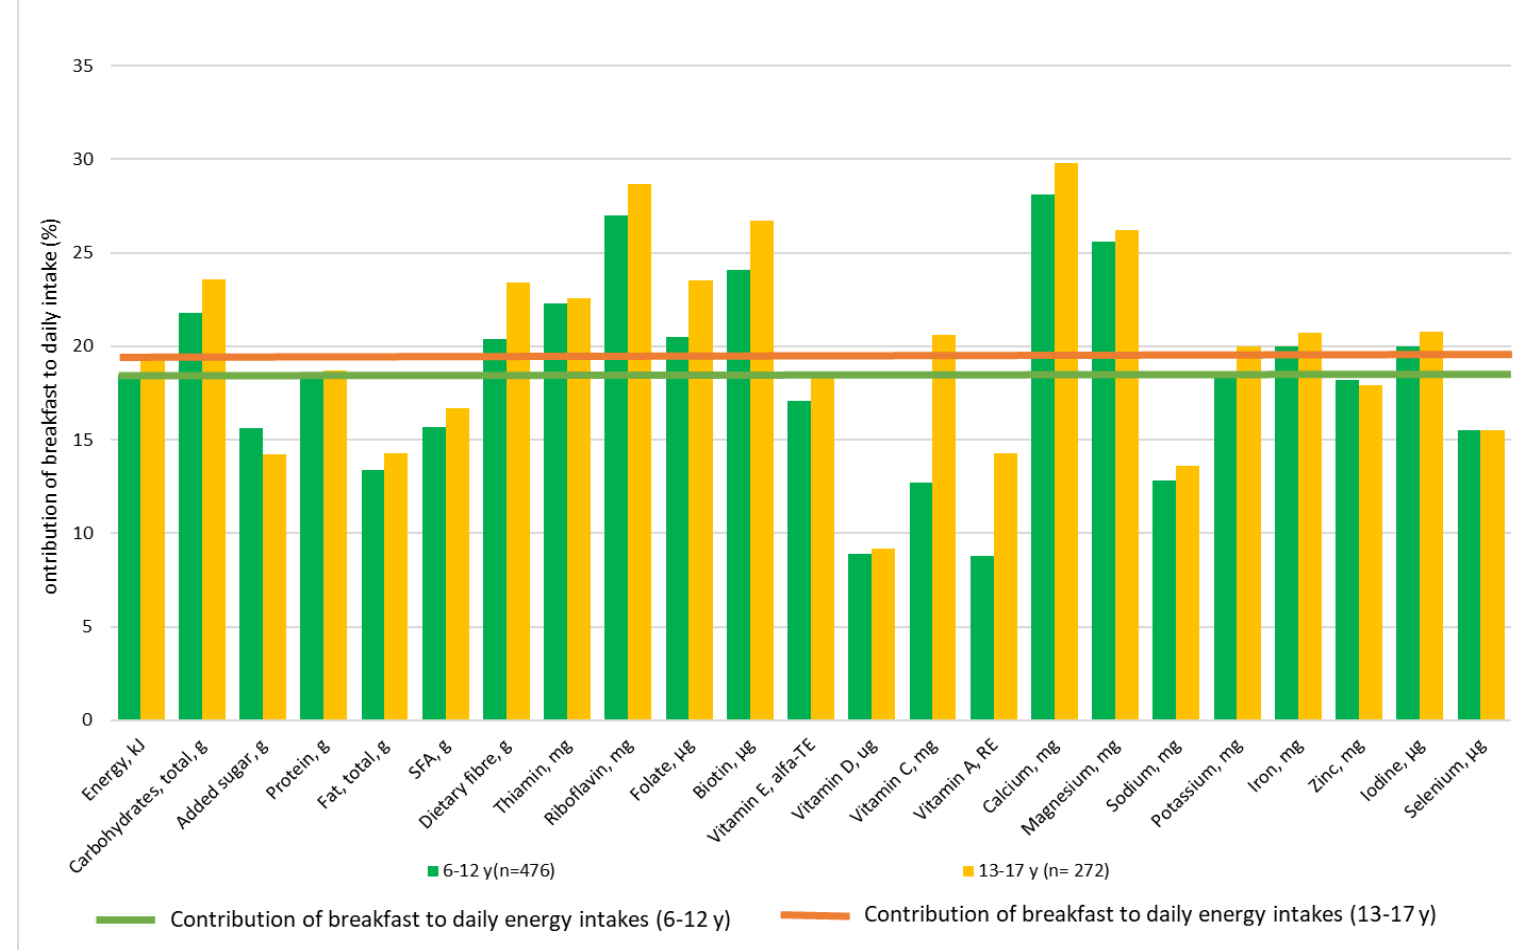
Figure 2. The contribution of breakfast (%) to the daily nutrient intakes in 6–12 and 13–17 year-old Danes.